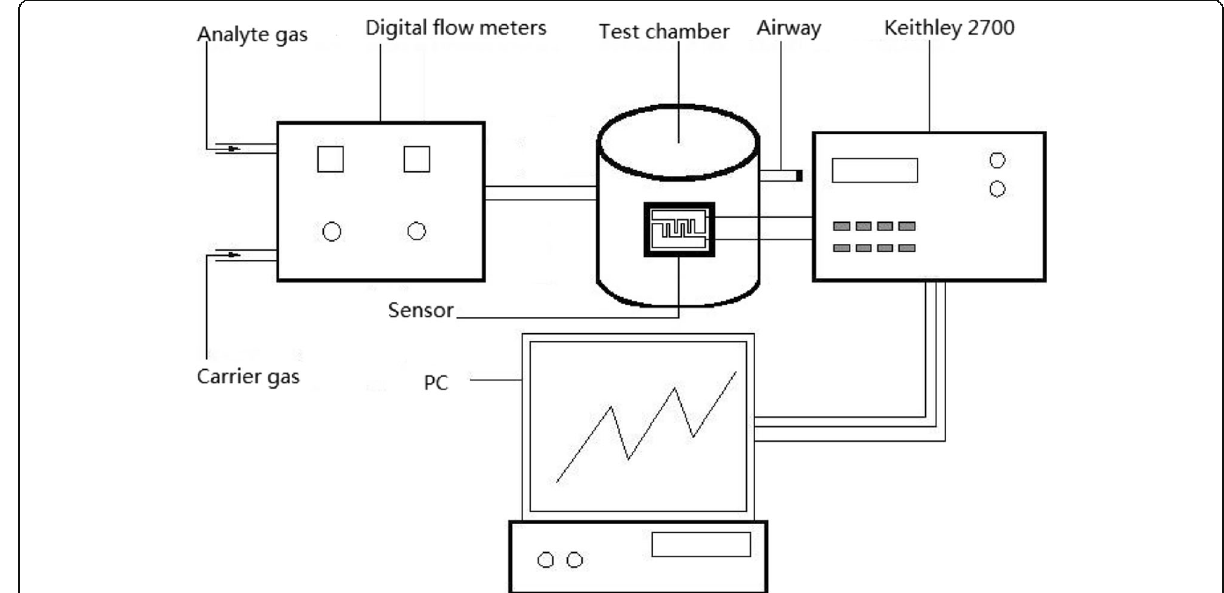
Fig. 2 The setup employed for gas